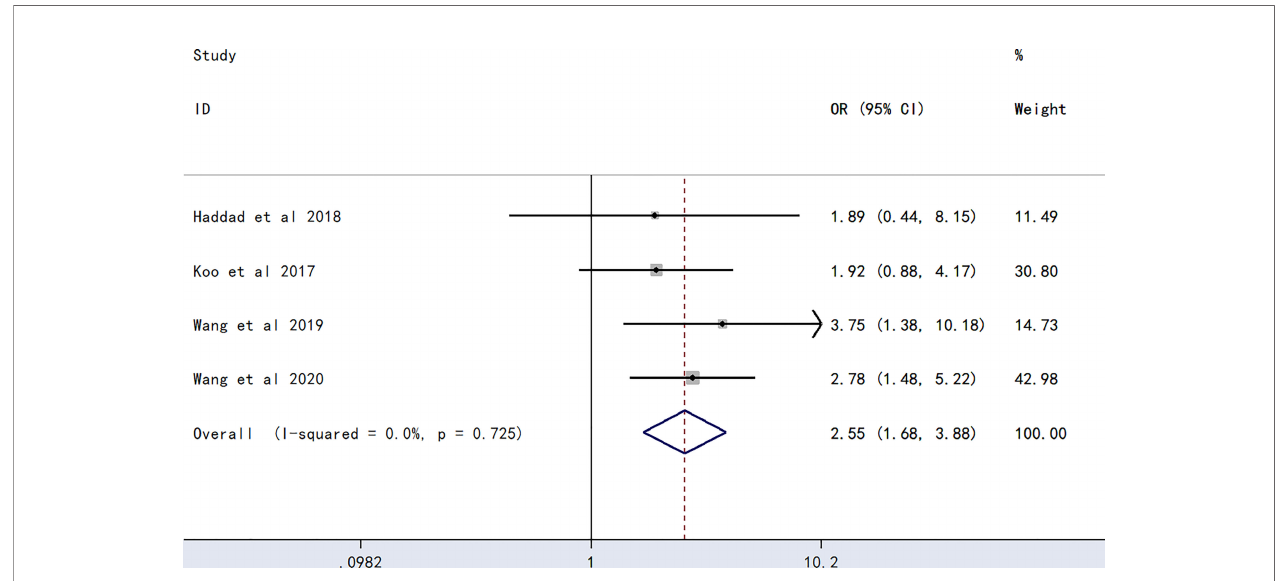
FIGURE 5 | Forest plot evaluating the association between PICC-associated VTE and the prevalence of AB blood